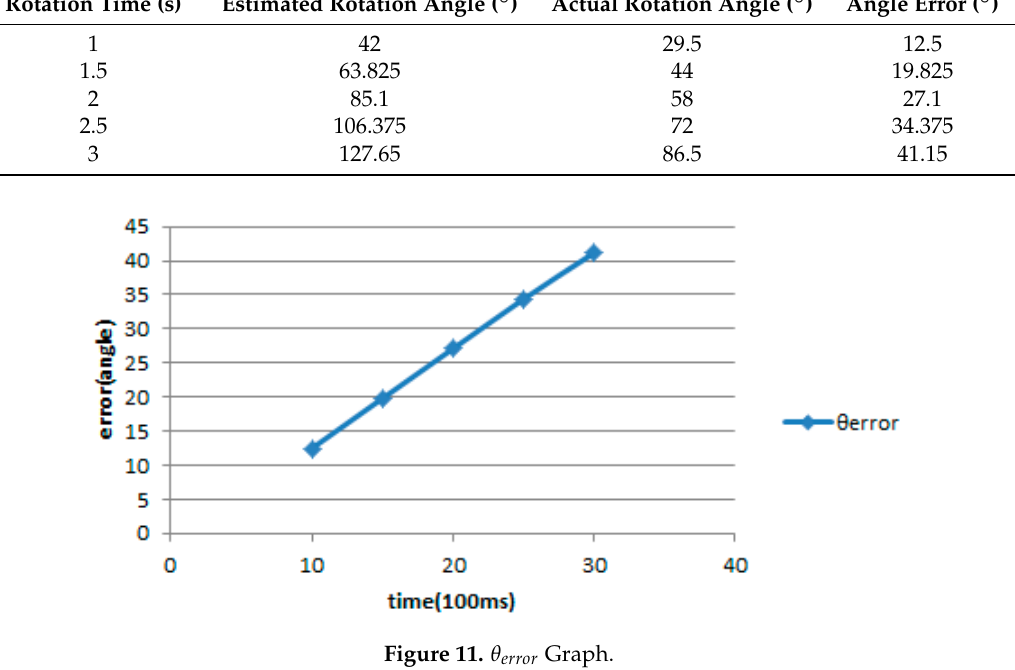
Figure 11. (cid:2016) (cid:3032)(cid:3045)(cid:3045)(cid:3042)(cid:3045) Graph. Figure 11. θ error Graph.